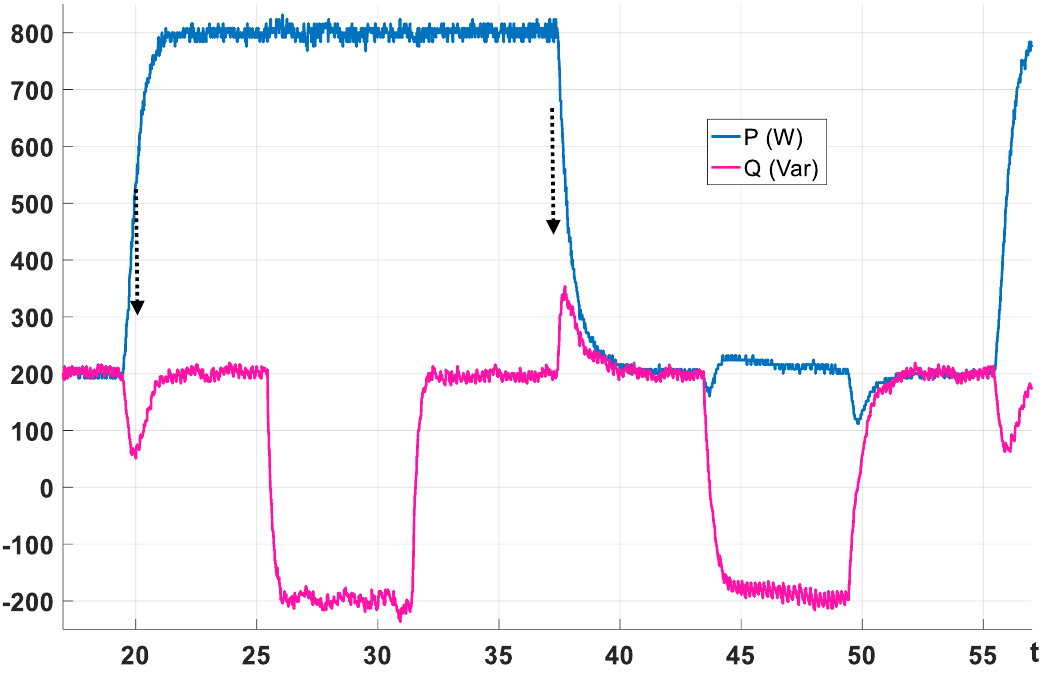
Figure 12. Response of Power Transformation Matrix (PTM) method to big step changes of P set and Q set .